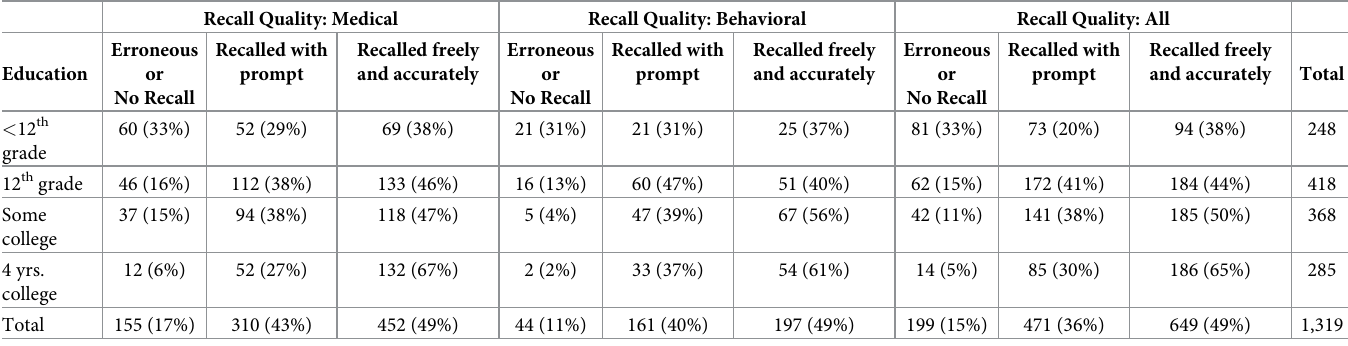
Table 2. Recall quality of medical and behavioral resolutions and patient level of formal education (N, row % within category). Recall Quality: